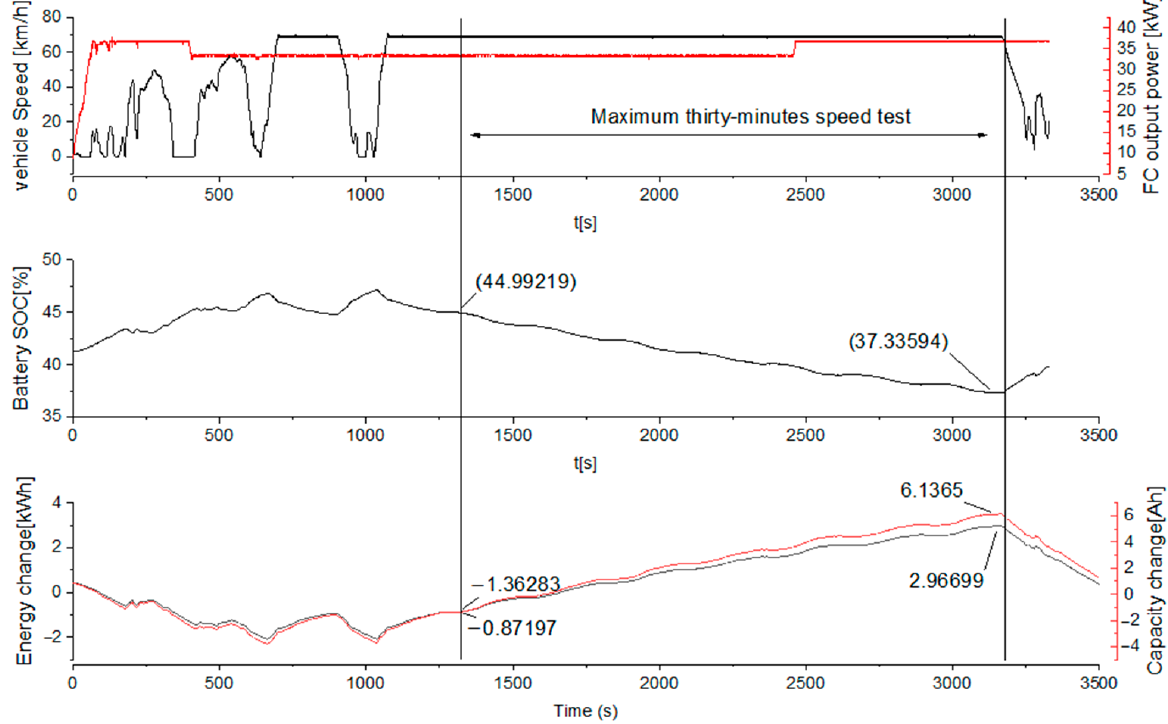
Figure 3. Maximum thirty-min speed test results.